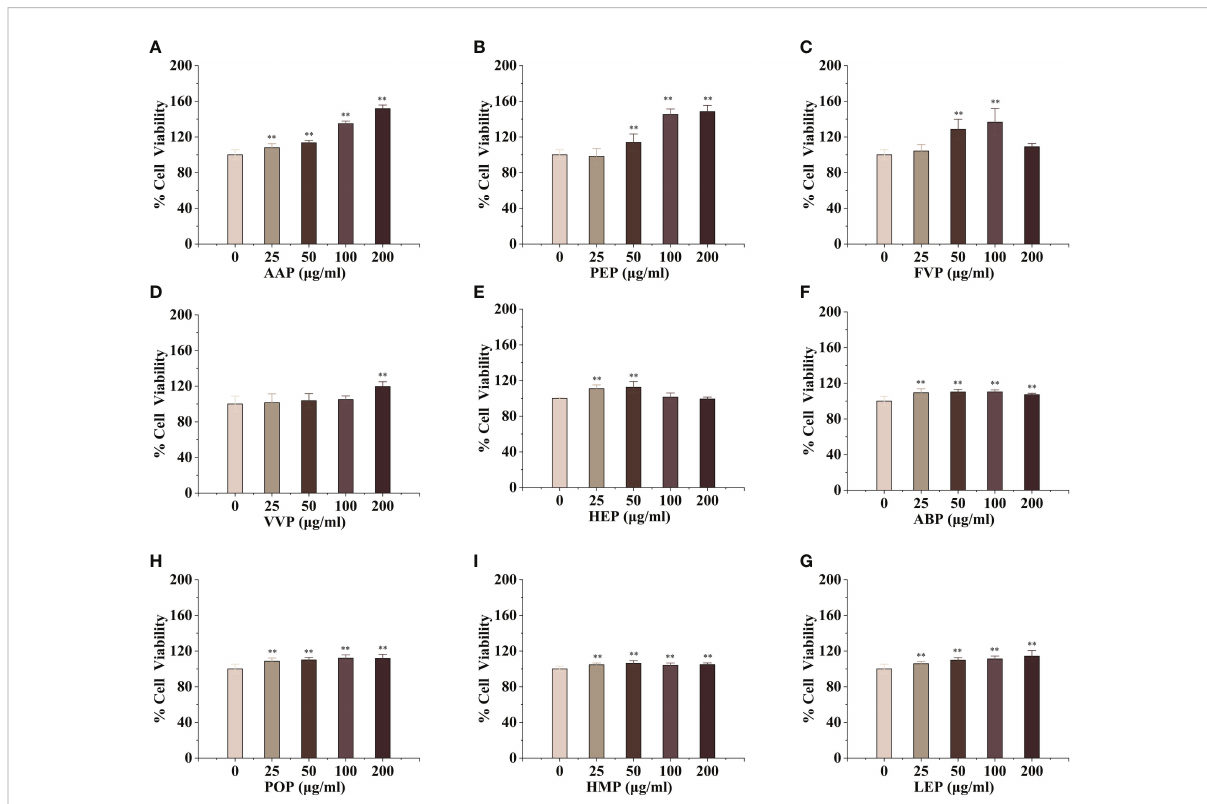
FIGURE 2 Proliferative effects of nine common edible mushroom proteins on RAW 264.7 cells. AAP (A) , PEP (B) , FVP (C) , VVP (D) , HEP (E) , ABP (F) , LEP (G) , POP (H) and HMP (I) on the proliferation of RAW 264.7 macrophages. Data are expressed as mean ± SD (n = 5). **P < 0.01; compared with the control